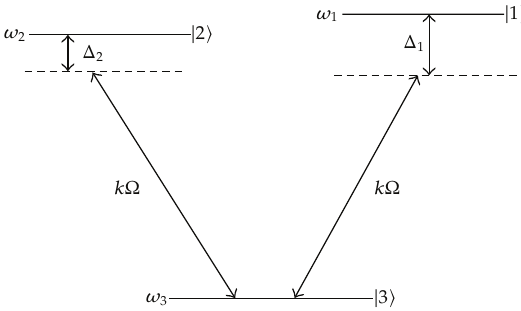
Figure 1: Energy level diagram for a V -type three-level atom with k -photon detuning Δ 1 , Δ 2